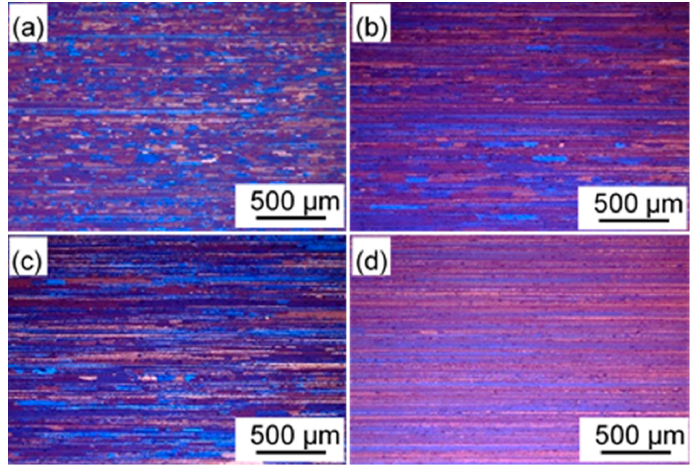
Figure 3. Longitudinal sectional metallographic pictures of solutionized samples after ramp heating-up treatments. ( a ) Direct solution; ( b ) ~10 °C /min; ( c ) ~5 °C /min; and ( d ) < 2 °C /min.